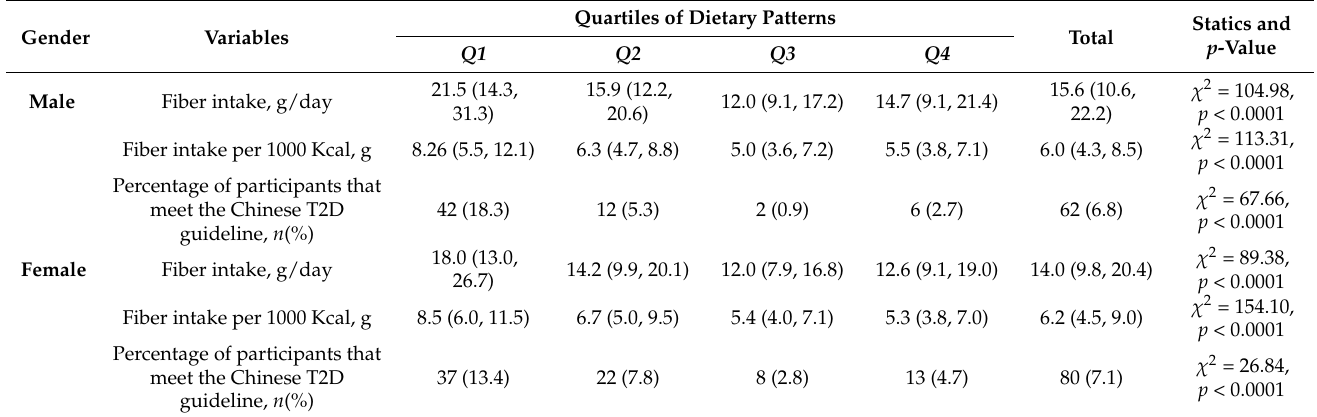
Table 6. Fiber intake analyzed by quartile levels of dietary pattern score in this study ( M ( P 25 , P 75